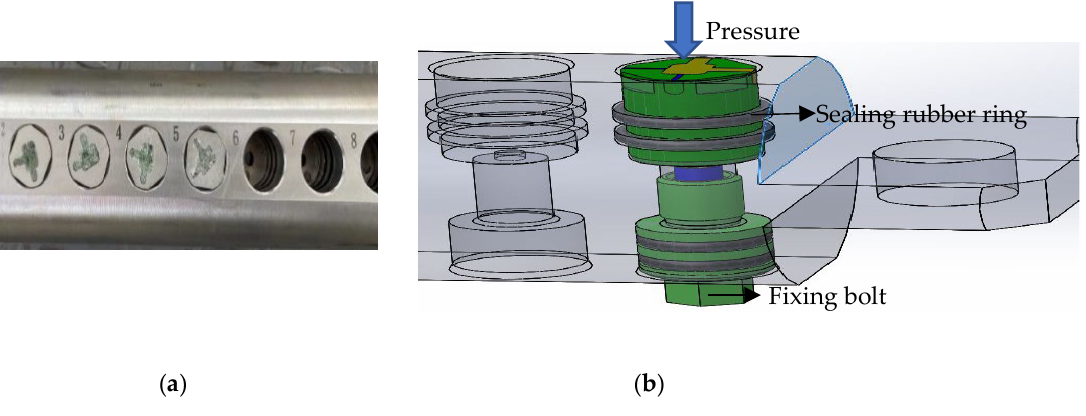
Figure 12. Antenna performance verification device: ( a ) the verification device; ( b ) 3D model of verification device.